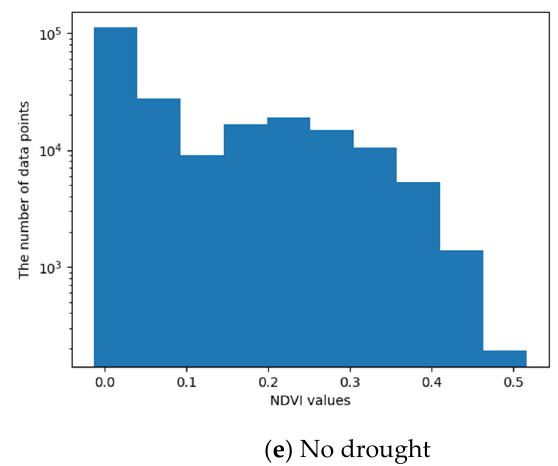
Figure 3. The statistical distribution of NDVI values for five drought categories in January 2015 for the Temperate Region of Australia. Figures ( a )–( e ) represent the statistical distribution of five drought categories, respectively.